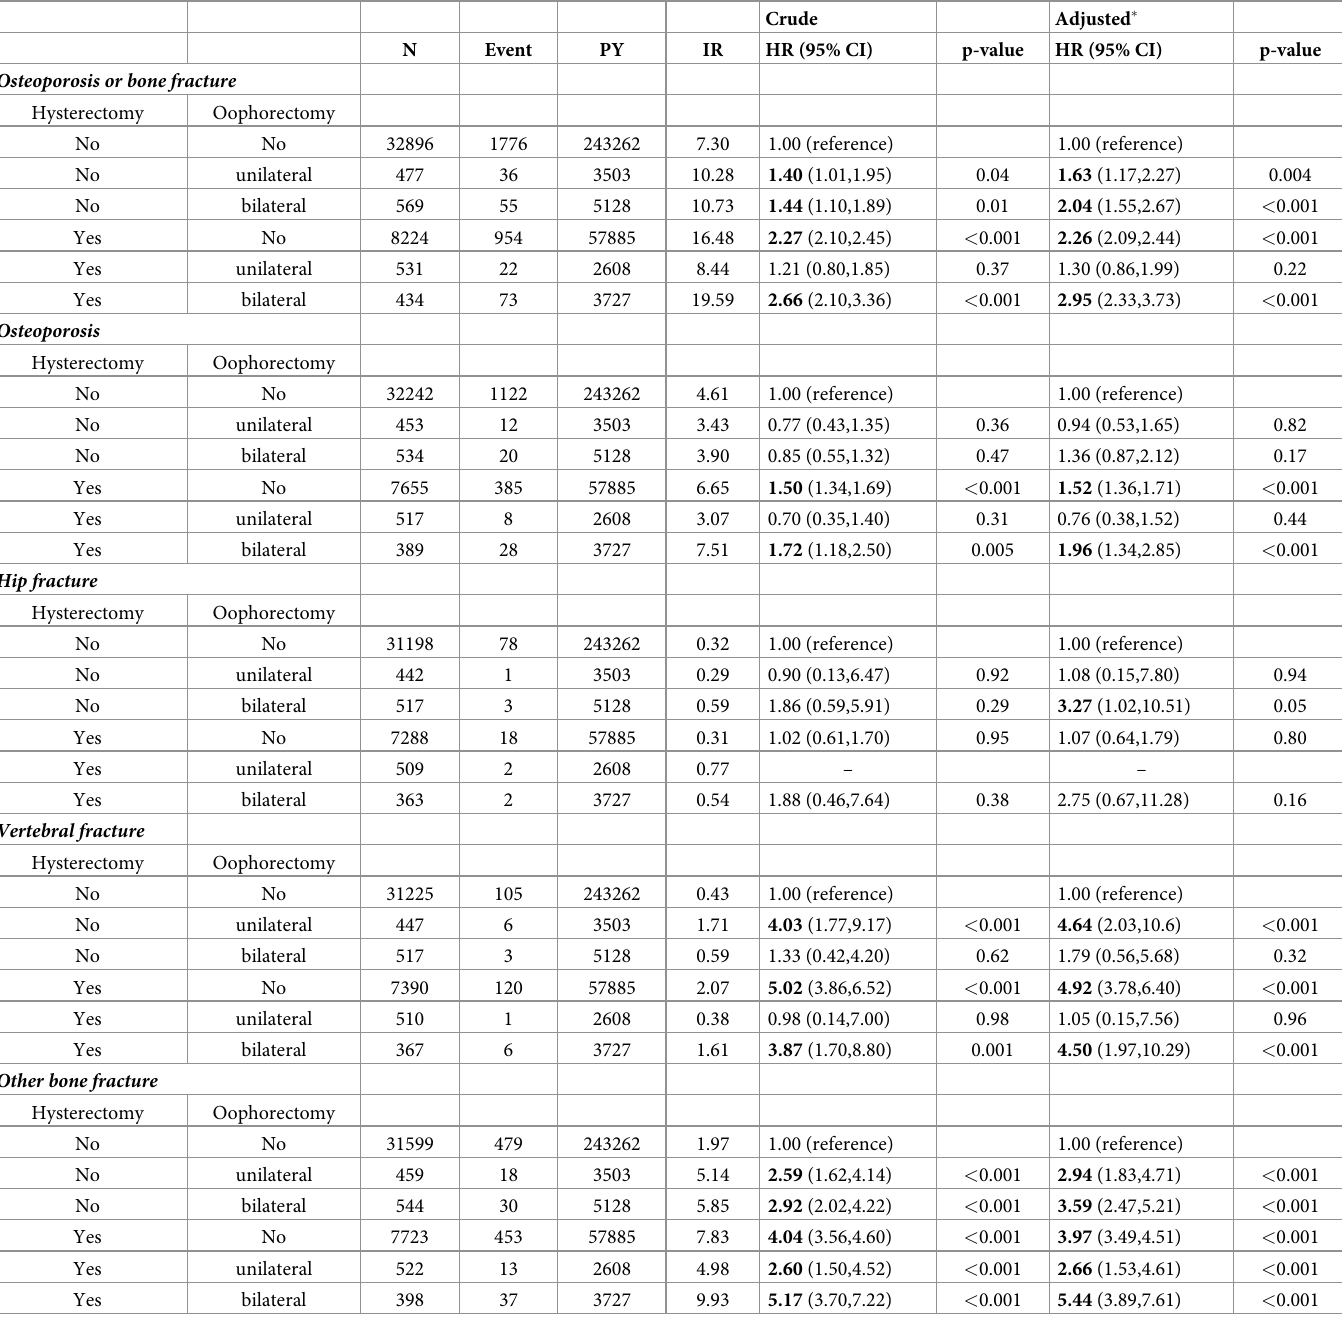
Table 2. Incidence rate and hazard ratio of osteoporosis or bone fracture in women with hysterectomy and oophorectomy compared with the comparison group.